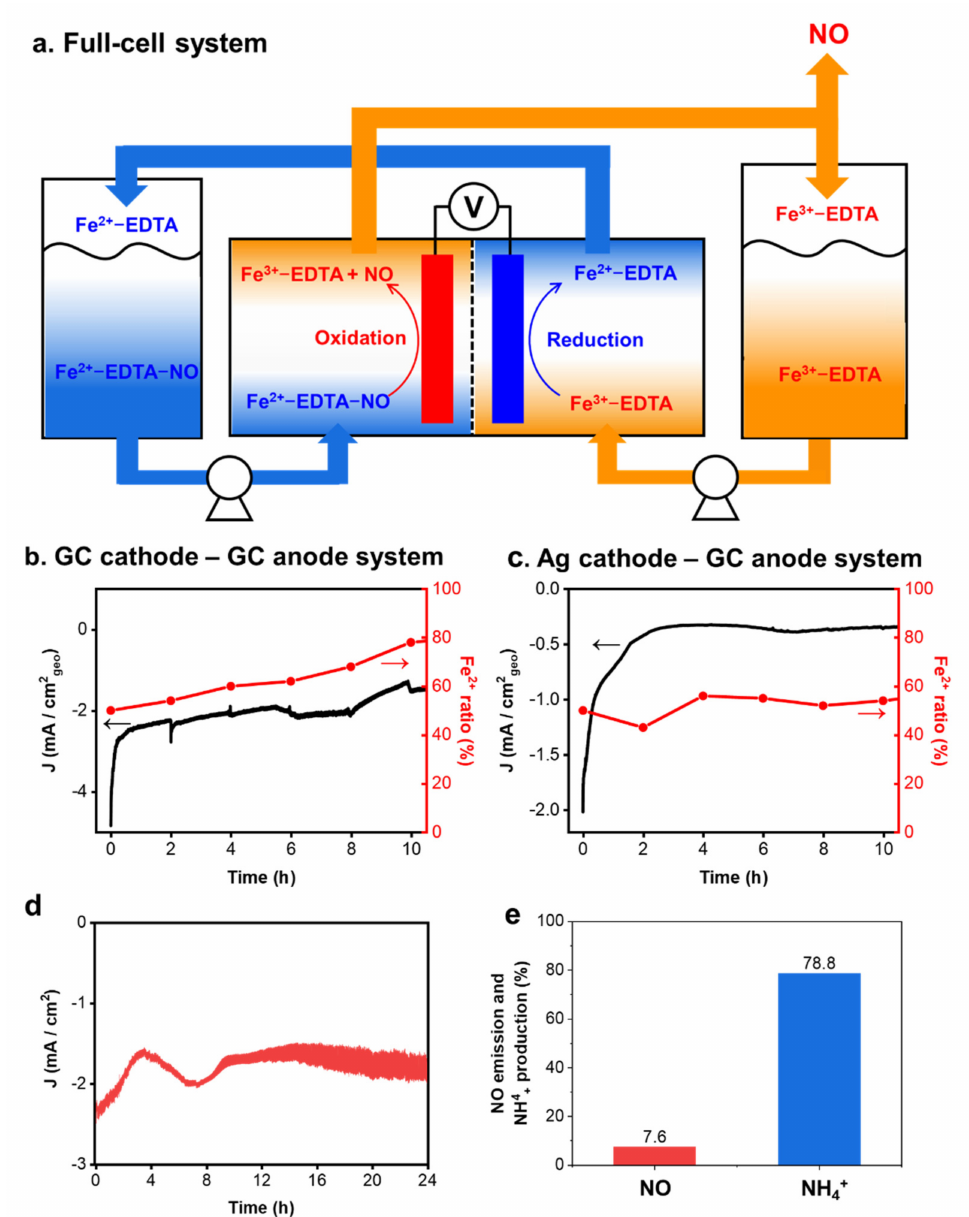
Figure 4. ( a ) Schematic description of full-cell system to examine sustainable NO removal property using electrochemical Fe 2+ / 3+ -EDTA redox reaction. J-t and Fe 2+ ratio–time curves of the constant potential full-cell reaction using ( b ) GC cathode and anode at − 2.0 V and ( c ) Ag cathode and GC anode at − 1.5 V in a 10 mM Fe 2+ -EDTA dissolved 0.1 M Na 2 SO 4 aqueous solution (pH 2.7). The flow rate of the electrolyte circulation was 4 mL min − 1 . ( d ) J-t curve of the constant potential full-cell reaction with the NO absorbed 30 mM Fe 2+ -EDTA (Fe 2+ -EDTA-NO) dissolved 0.1 M Na 2 SO 4 solution (pH 2.5) at − 1.5 V vs. RHE for 24 h. ( e ) The amount of NO emission and NH 4+ production from the 30 mM NO by the full cell